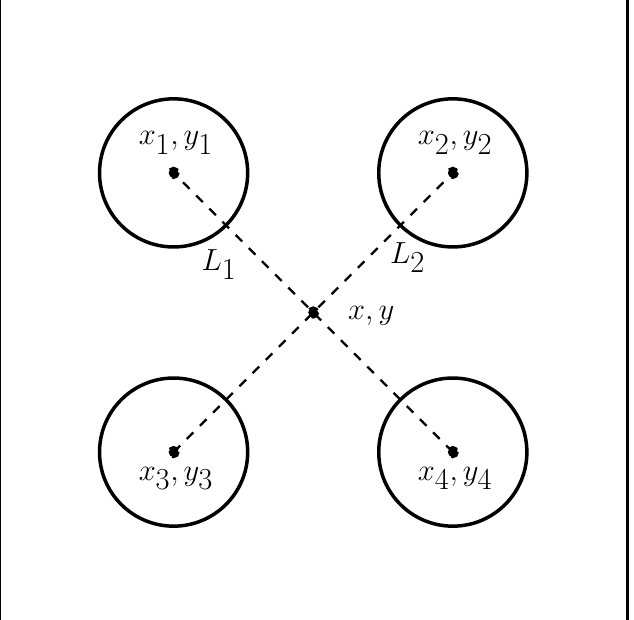
Figure 6. The figure shows the centers of four circles, two lines ( l 1 , l 2 ), and the middle point